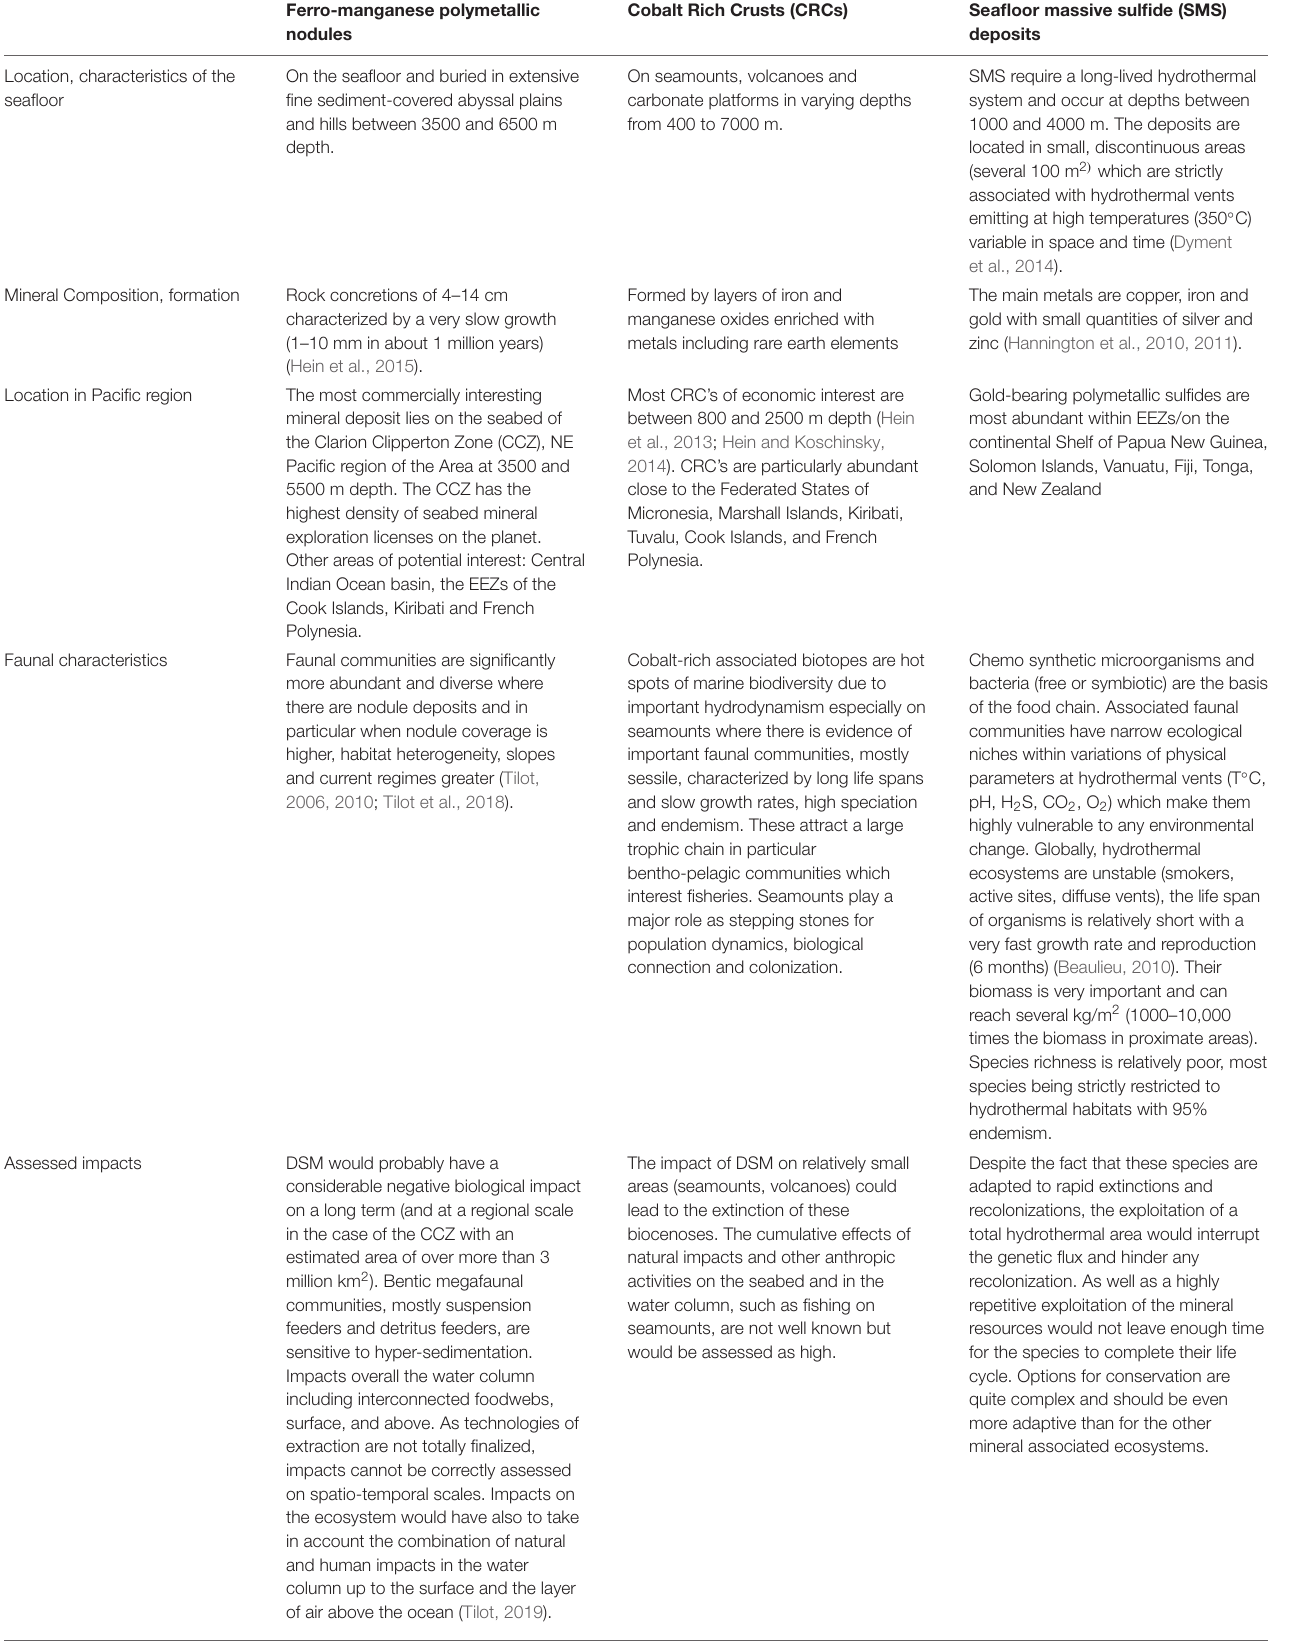
TABLE 1 | The characteristics of three main types of seabed mineral resources on the deep seabed of the Pacific region targeted by